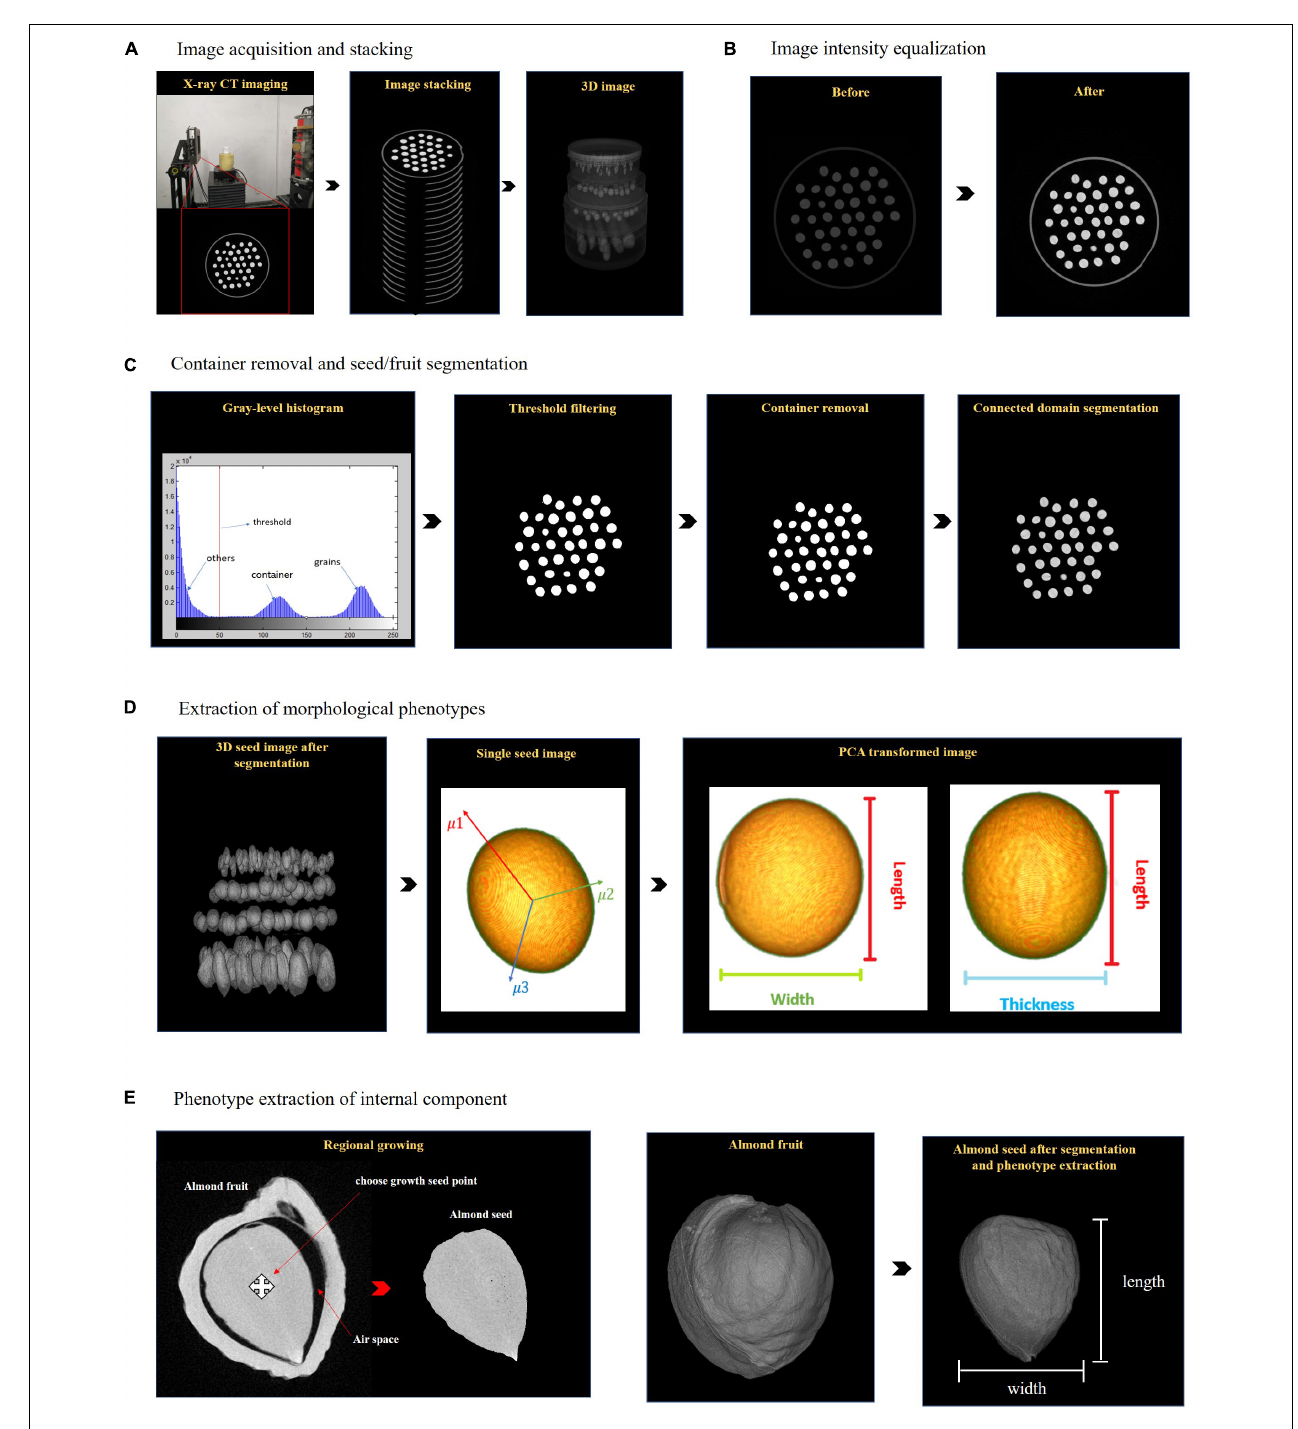
FIGURE 1 | X-ray computed tomography image acquisition and processing pipeline for high-throughput phenotyping morphological characteristics of seeds/fruits. (A) Image acquisition and 3D reconstruction. (B) Image intensity equalization. (C) Container removal and object plant tissue segmentation. (D) Morphological phenotype extraction. (E) Internal component segmentation and phenotype extraction.